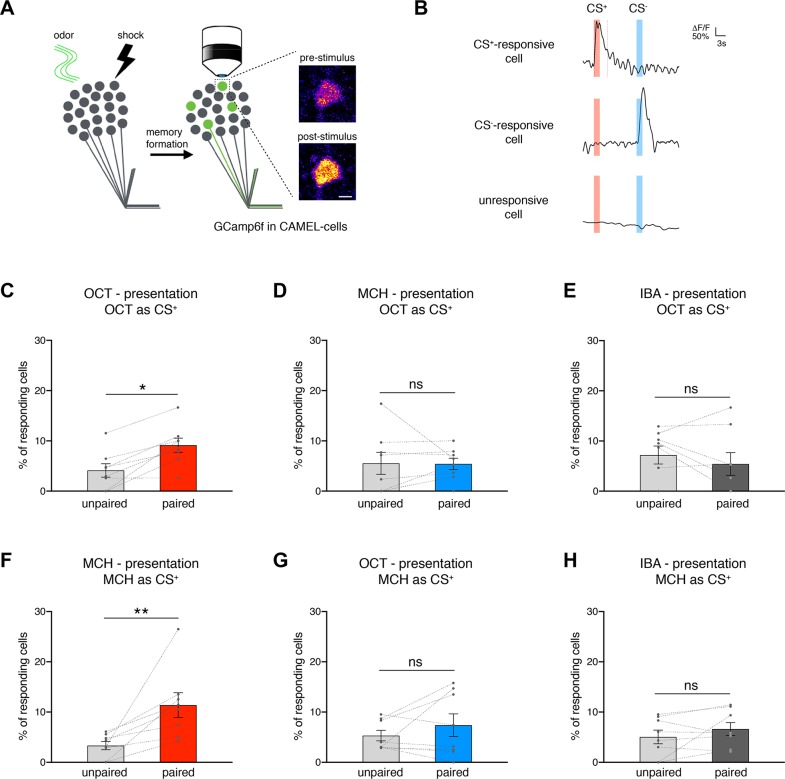
Natural recall cue activates CAMEL cells in vivo.(A) Schematic of the experimental design. Exemplary KC soma in vivo recording shows increased GCaMP6f response after presentation of an olfactory cue (OCT) to the fly’s antennae. (B) Three GCaMP6f example traces of individual KCs (upper trace from example in panel A). Red (CS+, OCT) and blue (CS−, MCH) bars indicate odor presentation time window, and red dashed lines indicate the time window for analysis (0–4.5 seconds post stimulus). (C–E) LTM conditioning (OCT as CS+) significantly increased the percentage of CAMEL cells responding to OCT (CS+, panel C) compared to control flies (unpaired training) 3–4 days after conditioning (n ≥ 8; 10–55 cells per n; total ≥ 249 cells). No difference was observed for MCH-responding cells (CS−, panel D) or cells that respond to a training-unrelated odor (IBA, panel E). (F–H) Conditioning using reversal of odors (MCH as CS+ and OCT as CS−) again resulted in an increased percentage of CAMEL cells responding to the CS+ (MCH, panel F) but not to the CS− (OCT, panel G) or IBA (panel H) (n ≥ 8; 19–47 cells per n; total ≥ 240 cells). (C–H) All data were acquired 3–4 days after training, and each n represents data from an independent round of conditioning (6xCREAD∩R21B06DBD > GCaMP6f, tdTomato). Bars represent mean ± SEM (lines connect data points collected in parallel on the same day). Scale bar corresponds to 2.5 μm. Asterisks indicate significant differences between relevant groups (*P < 0.05, **P < 0.01, unpaired t test). CAMEL, CRE-activity–dependent memory engram label; CRE, cAMP response element; CS, conditioned stimulus; GCaMP,; IBA, Isobutyl-acetate; KC, Kenyon cell; LTM, long-term memory; MCH, 4-Methyl-cylohexanol; ns, not significant; OCT, 3-Octanol; SEM, standard error of the mean.